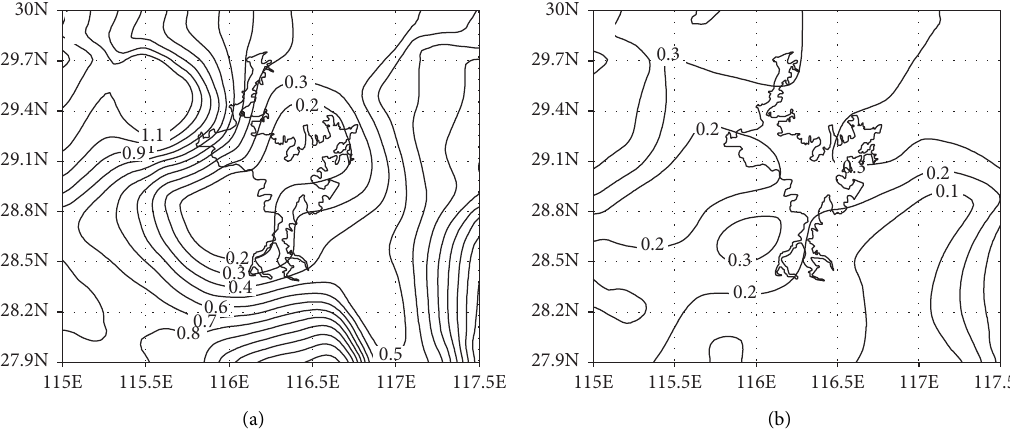
Figure 5: The amplitudes of (a) diurnal (24hours) cycle and (b) semidiurnal (12hours)